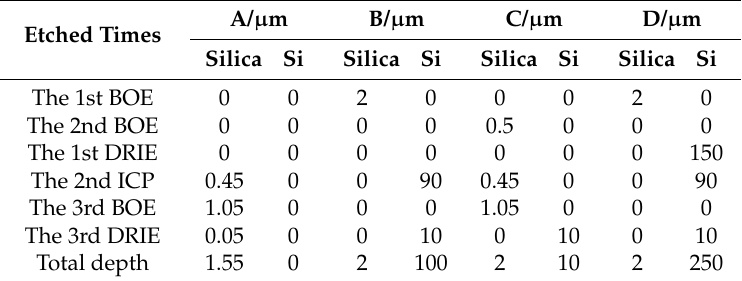
Table 1. Depth details of the wafer after each etch.